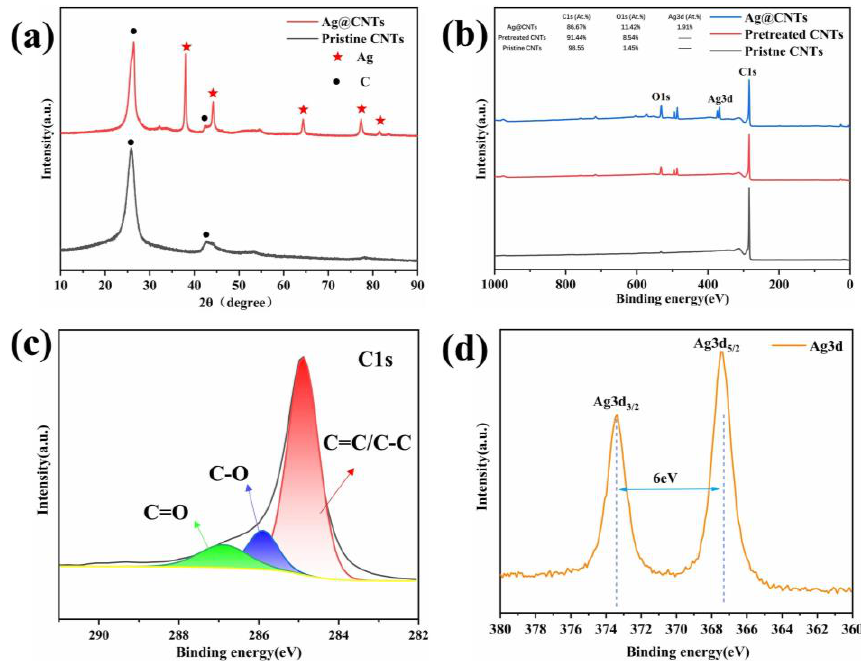
Figure 2. ( a ) XRD patterns of pristine CNTs and Ag-CNTs; ( b ) XPS spectra of pristine CNTs, pretreated CNTs and Ag-CNTs; ( c ) XPS C1s spectrum of Ag-CNTs; ( d ) XPS Ag3d spectra of Ag-CNTs.